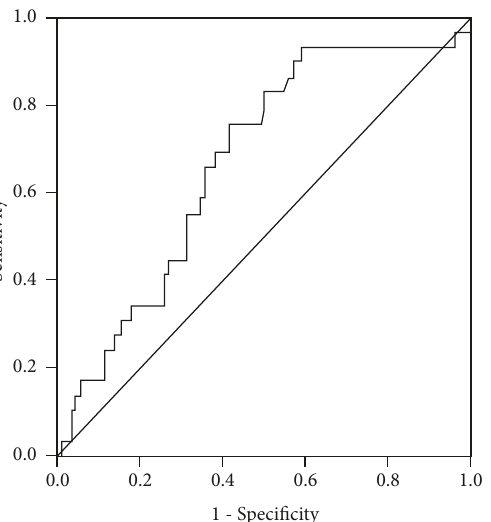
Figure 1: Receiver operating characteristic analysis displaying the power of shock index in the prediction of slow/no reflow